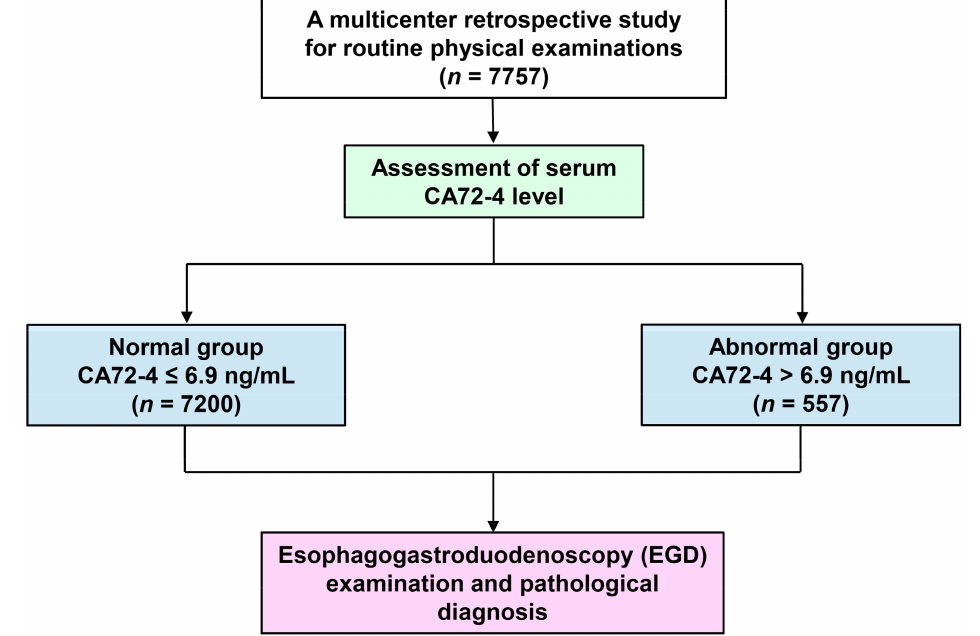
Figure 1. Flowchart of the population selection, identification, and analysis in a multicenter retrospective